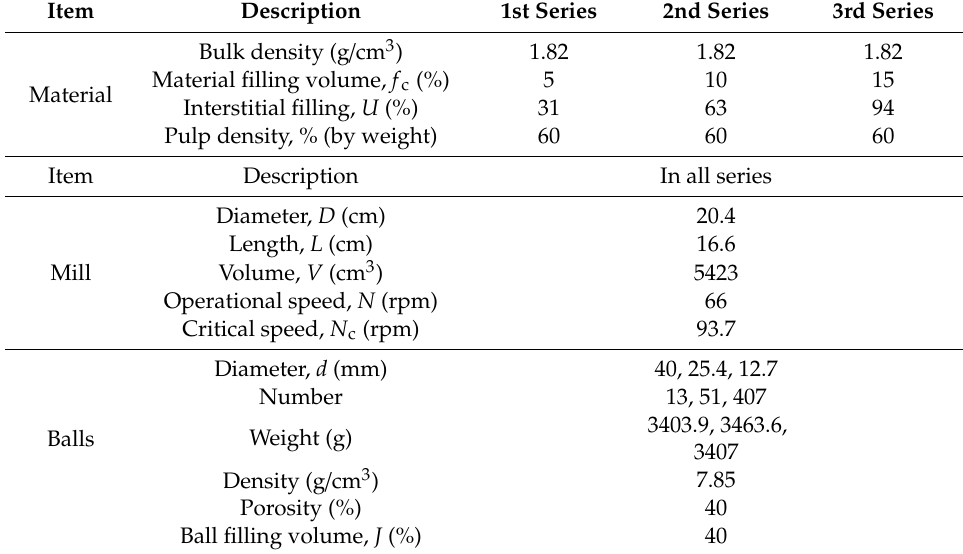
Table 1. Mill specification data and test